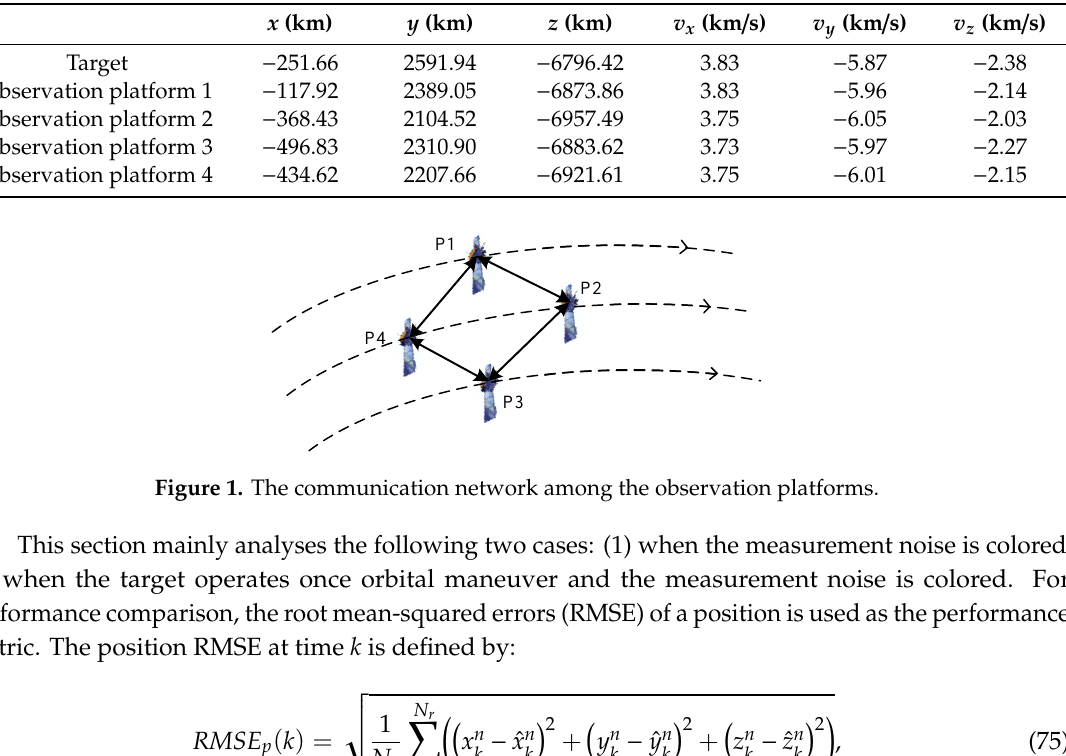
Table 2. The initial positions and velocities of target and observation platforms.